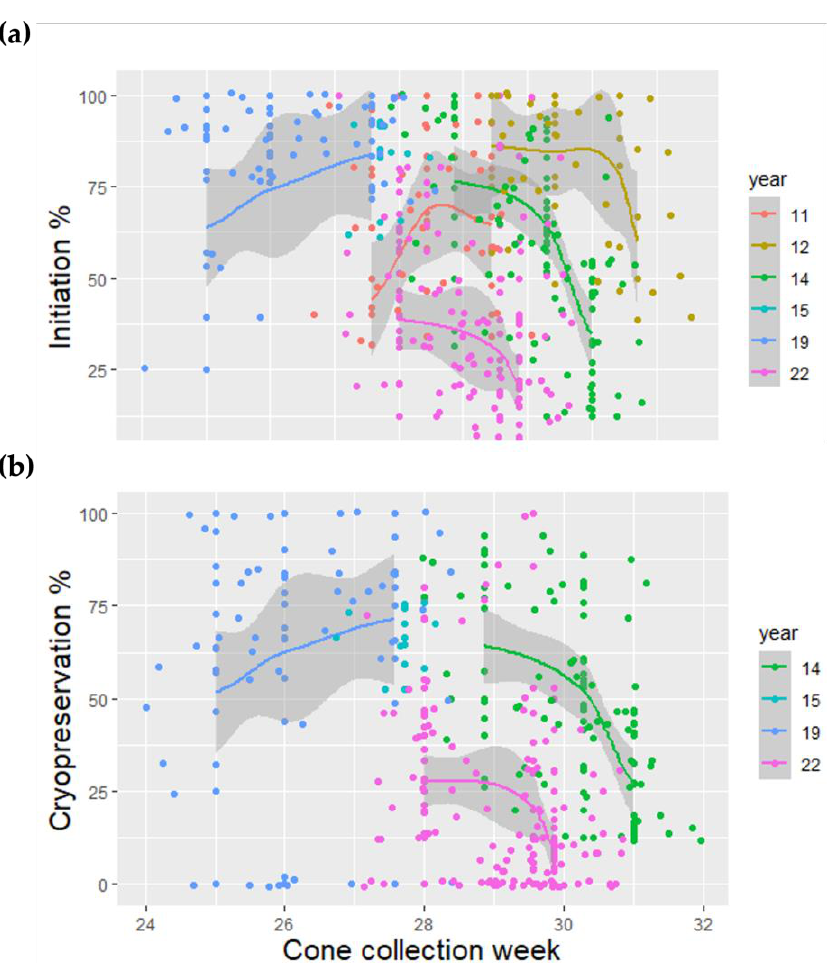
Figure 3. The effect of cone collection date on initiation ( a ) and cryopreserved ET ( b ) of Norway spruce SE cultures. Each dot represents the mean initiation or cryopreserved ET percentage of each family according to the cone collection date.